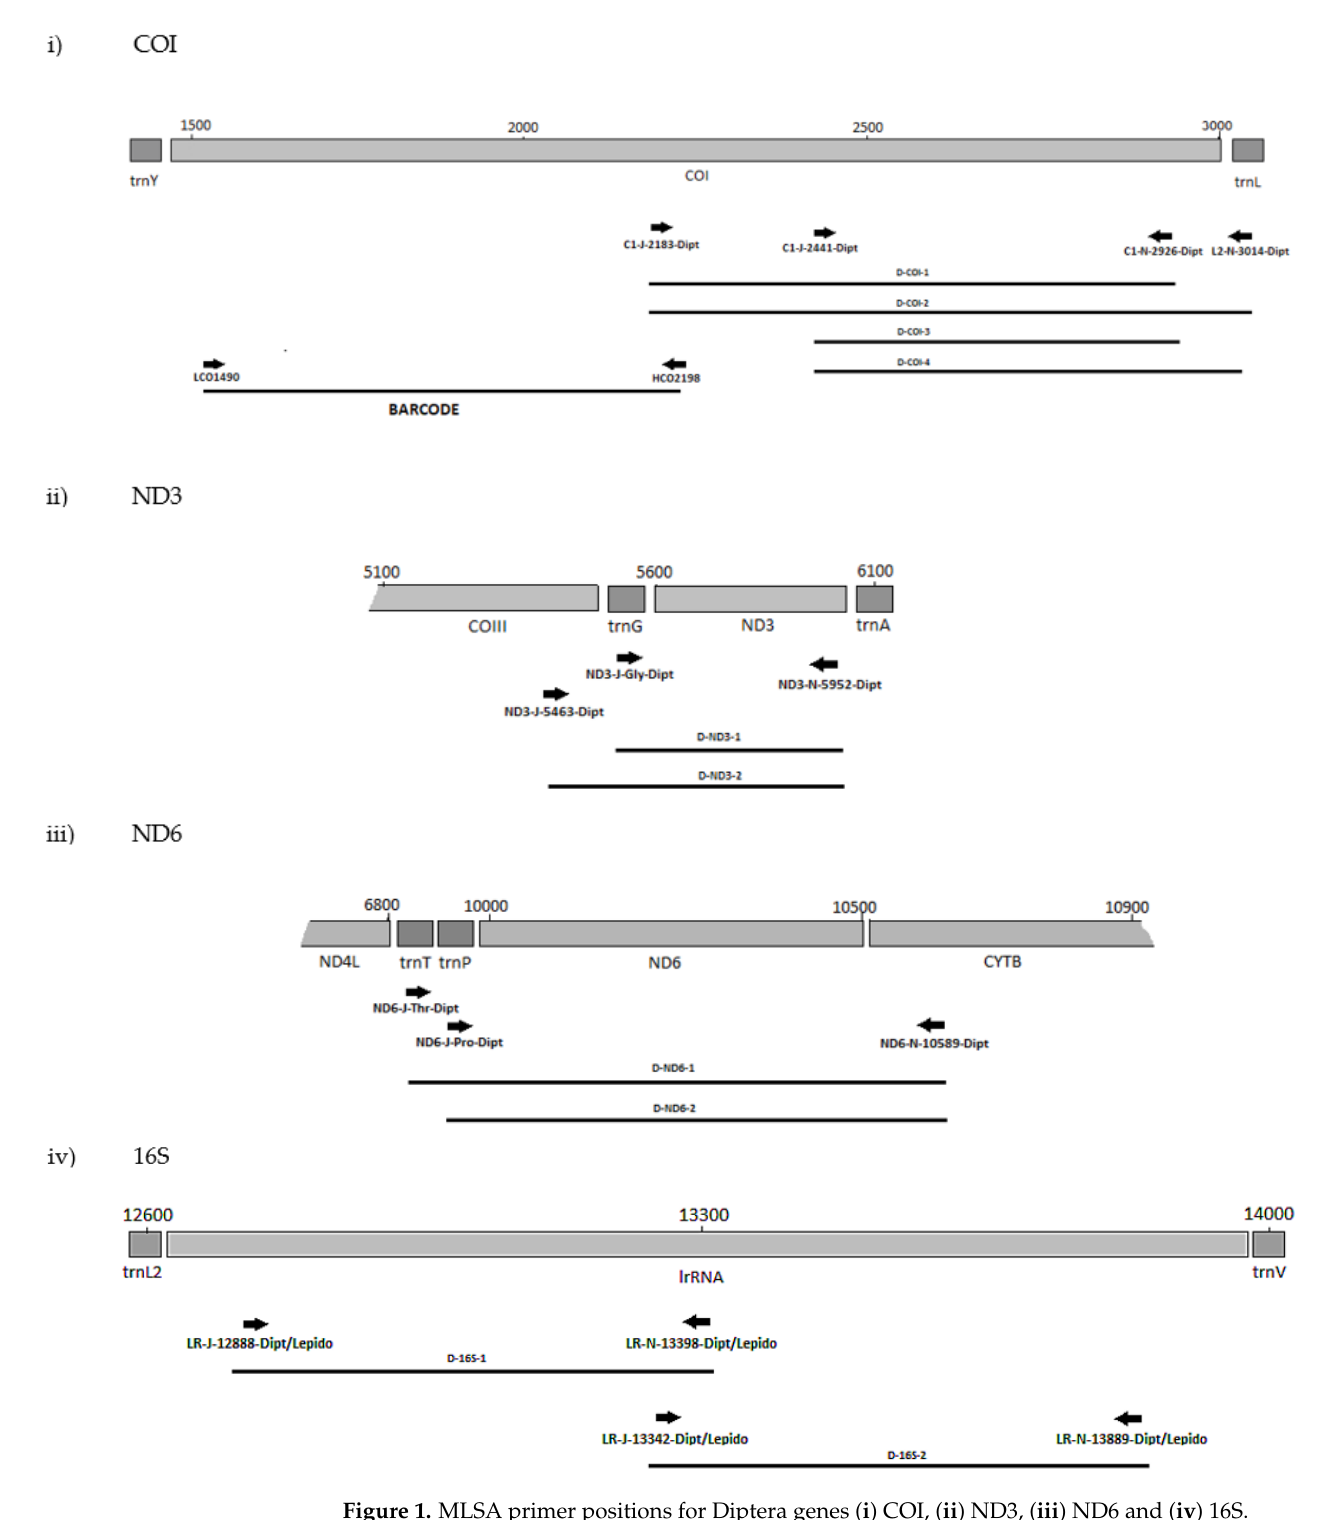
Figure 1. MLSA primer positions for Diptera genes (i) COI, (ii) ND3, (iii) ND6 and (iv) 16S. That primer set, ND6-J-10070-Dipt/ND6-N-10589-Dipt/Lepido, also failed with B. dorsalis and B. tryoni . However, as the reverse primer 10589-Dipt/Lepido was still success- ful with other forward primers, only the highly degenerate primer ND6-J-10070-Dipt was excluded from further testing. In addition, the primer sets C1-J-2195-Dipt/C1-N-2926- Dipt, C1-J-2195-Dipt/L2-N-3014-Dipt, and C1-J-2441-Dipt/C1-N-2776-Dipt for COI- 3′ were unsuccessful with the Bactrocera species, and as the position of their amplicons over- lapped with the successful sets of D-COI-1 (CI-J-2183-Dipt/CI-N-2926-Dipt) and D-COI-2 (CI-J-2183-Dipt/L2-N-3014-Dipt), they were also excluded from the further testing. All ND3 and 16S primer sets were very efficient with both D. melanogaster and all the Bac- trocera species. Positions of the final primer cohort are illustrated in (Figure 1). Successful primer sets (Table 3 and Figures 1 and 2) from the preliminary tests were then assessed with a further 37 dipteran taxa across 13 additional families (Table 4). For most of the taxa, all primer sets performed well (Table S7). When considering families represented by more than one specimen, the only exception was the primer sets for both ND genes primers and the fungus gnats of the Sciaroidea, with D-ND3-1, D-ND6-1, and D-ND6-2 negative reactions for the Mycetophilidae and Sciaridae and D-ND3-2 also for the Mycetophilidae. Conclusions at the family level for the Ephydridae with D-ND6-2 are difficult to make with negative reactions for the single representative species Hydrelia trit- ici . The Culicidae and Lonchopteridae were each represented by a single specimen of one species; therefore, while positive reactions can be considered indicative of primer compat- ibility, conclusions from negative reactions cannot be made (Table S7). The D-ND3-1 gen- erated two products with the lonchopterid specimen, potentially a result of internal prim- ing. Except for the tephritids, none of the families affected here contain plant pest species and had not been included in the primer design process. The few specimens of tephritids that failed also performed poorly with the 5′ COI barcode primers, possibly due to the age of the DNA samples. All these primers performed well with the majority of DNA samples prepared from specimens of exotic species intercepted at New Zealand’s border (Table S7). The main exception was D-ND6-2 which performed inconsistently with the agromyz- ids. For other species, some samples that gave negative results were positive when re-run with the high-fidelity polymerase Accuzyme (Tables 4 and S7), possibly due to the 3′ - 5′ proofreading exonuclease activity overcoming suboptimal template-primer PCR condi- tions or 3′ primer base mismatches [66]. In summary, these inconsistencies do not under- mine the taxonomically broad utility of the Dipteran primer sets. 3.2.2. Lepidoptera The plant pests P. brassicae and P. rapae (Pieridae) were used in a preliminary screen of all the lepidopteran primer sets (Table 3, Figure 2). Correct amplicons were produced for all four genes, and so a further 55 species for a total of 15 lepidopteran families were tested. The eight primer sets performed well for most taxa (Table 5). Of the 10 families represented by more than one species, exceptions were for negative reactions for the 5′